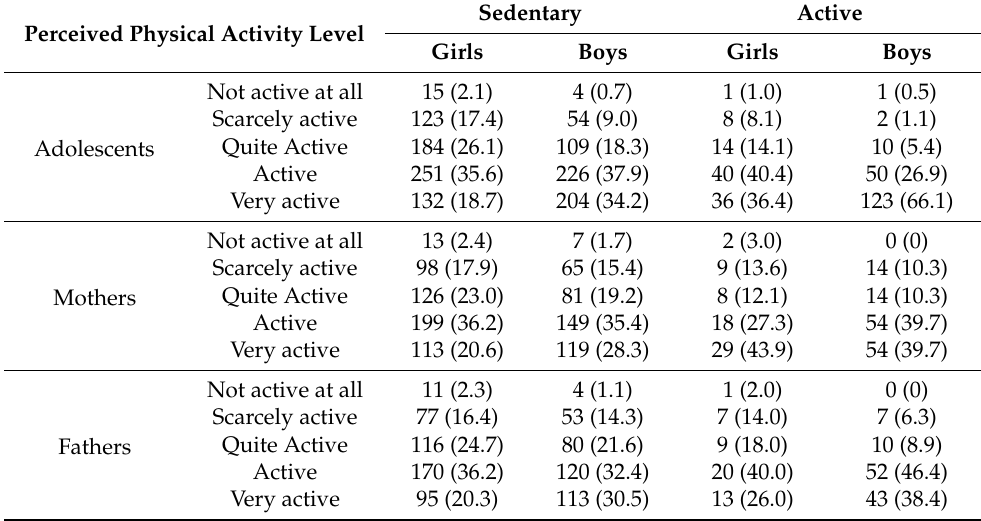
Table 4. Characterisation of perceptions about the level of physical activity of adolescents according to the level of true activity and